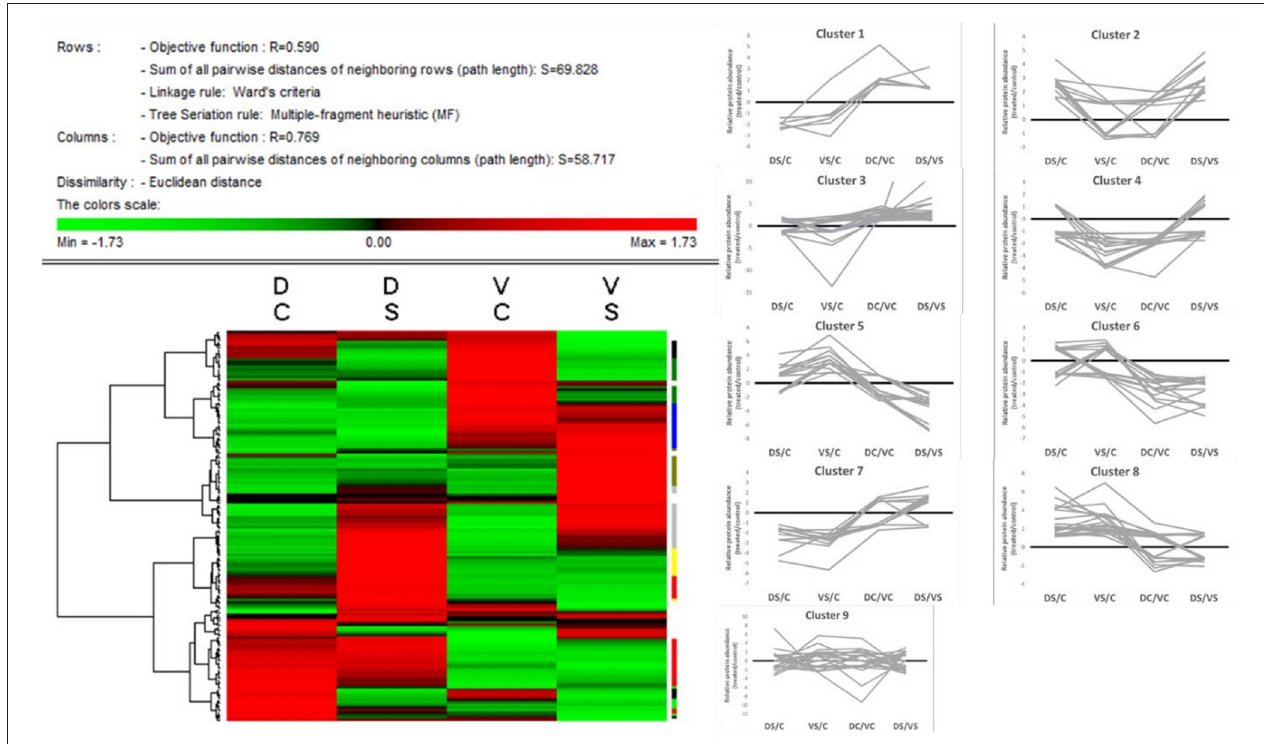
FIGURE 4 | Heat map + protein clusters. The compacted version of the heat map (Permut Matrix 1.9.3) of all 156 protein spot abundances, clustered according to the row Z-score values using Euclidean distance and Ward’s minimum criteria, calculated from protein spot abundances. The red values mean higher protein spot abundance in the samples; the green values mean lower protein abundance in the sample according to the variant (DC, Cadeli control; DS, Cadeli stress; VC, Viking control; VS, Viking stress). On the right side, the tiny color marks show nine different clusters, revealing information about the protein accumulation patterns. Clusters: 1, light green, higher in DC; 2, light yellow, higher in DS; 3, red, higher in both DC and DS; 4, green, higher in VC; 5, dark yellow, higher in VS; 6, blue, higher in both VC and VS; 7, black, higher in both controls; 8, gray, higher in both treated samples; and 9, white, miscellaneous patterns.